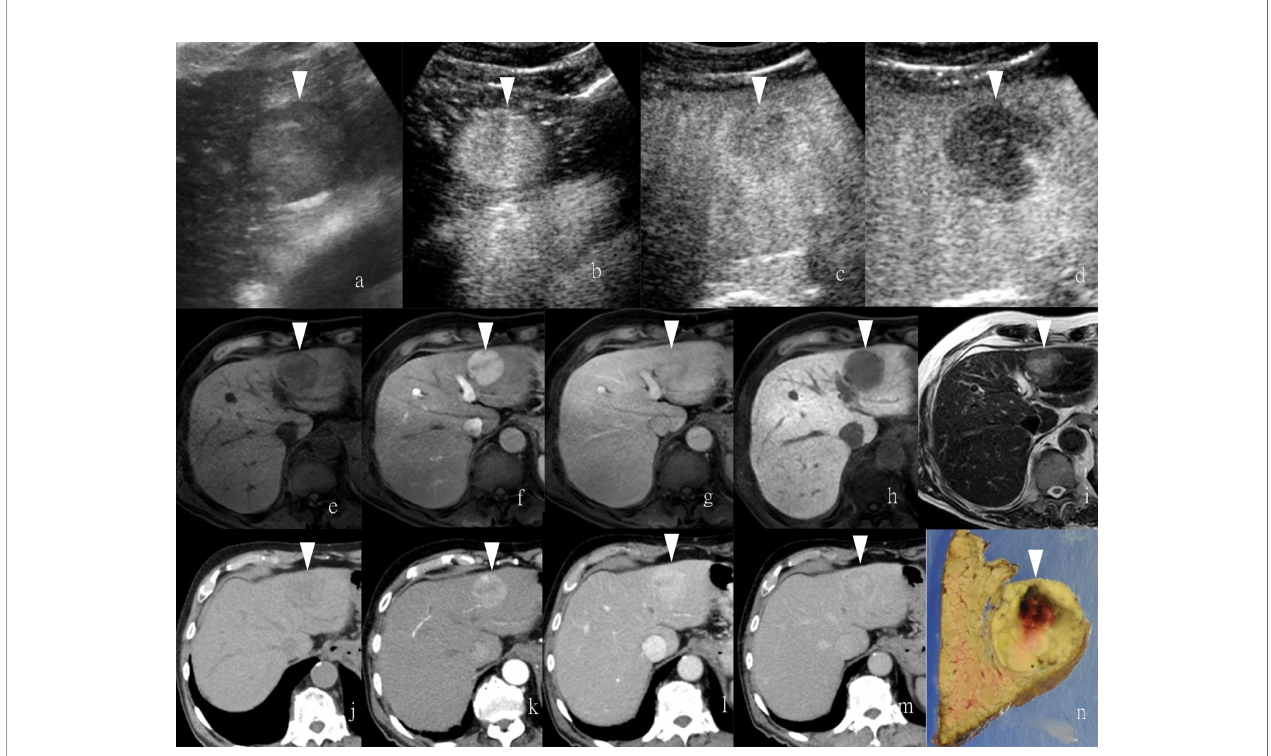
FIGURE 1 | Images of a man in his eighties with a pathological diagnosis of moderately differentiated hepatocellular carcinoma (HCC) and had a history of hepatitis (C) At the Sonazoid-enhanced ultrasound (US),the liver lesion at a size of 43 mm with a thin halo located at segment III was observed onB-modeUS (A) . It was rapidly enhanced inthe arterial phase (wash-in) (B) , started to fade(wash-out) in portal phase (C) , andwas totally exhaustedin the post-vascular phase (D) . At Gd-EOB-DTPA- enhanced MRI, the lesion was hypointense on T1-weighted image (E) , with the typical characteristics of wash-in and wash-out from arterialphase, portal phase, to delayed phase (F – H) . It showed hyperintensity on T2-weighted image (I) . At iodine agent-enhanced CT, ithas low-density before enhancement (J) . It also showed wash-in and wash-out from arterialphase, portal phase, to delayedphase (K – M) . Finally,the gross specimen vividly re fl ected the morphological information of tumor (N) . Arrowheads indicate the marginof the HCC